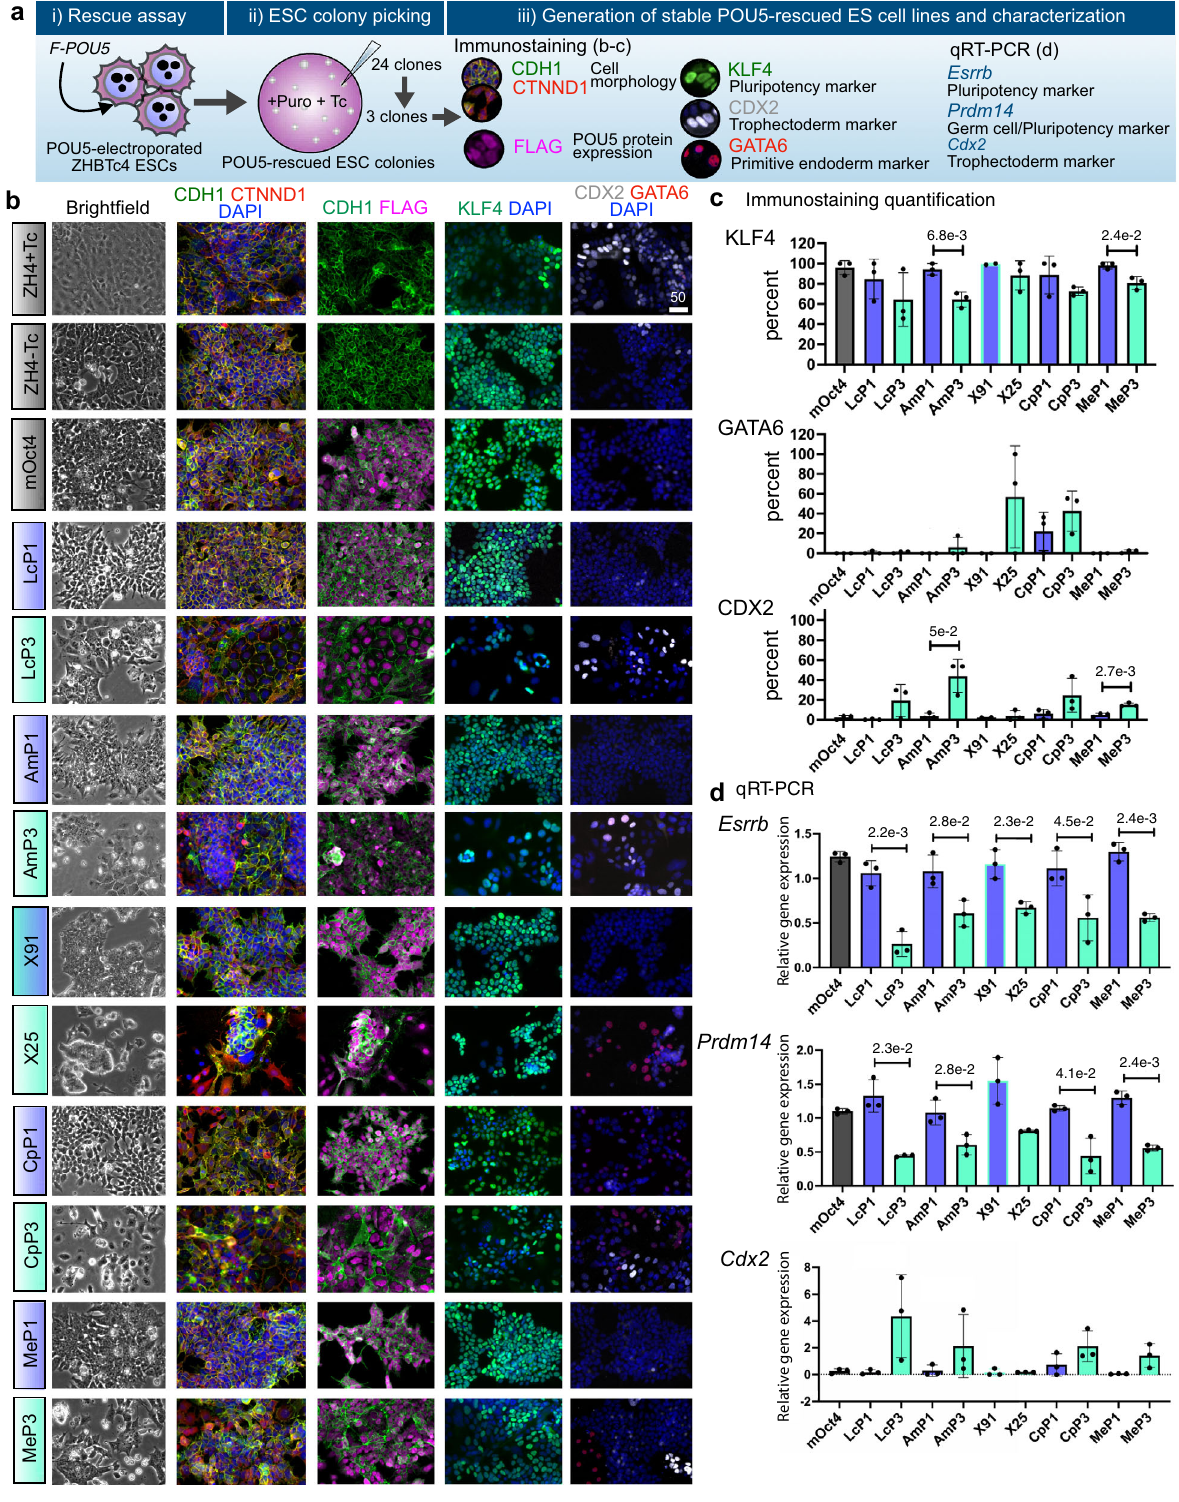
Fig. 3 | Phenotypes of ESC lines supported by sarcopterygian POU5 proteins. a Experimental strategy used to derive stable ZHBTc4 cell lines rescued by either POU5F1 (blue) or POU5F3 (teal) from coelacanth (Lc), axolotl (Am), frog (X), turtle (Cp) and wallaby (Me). b Representative immuno fl uorescencestaining of ZHBTc4- rescued cell lines. Anti-FLAG antibodies were used to detect and localize FLAG- tagged POU5 proteins, anti-KLF4 to assess pluripotency, anti-CDX2, anti-GATA6to assess differentiation and anti-CDH1 and anti-CTNND1 to assess cell morphology. c Quanti fi cationofbiologicalreplicatesfromimmuno fl uorescenceimagesshowing